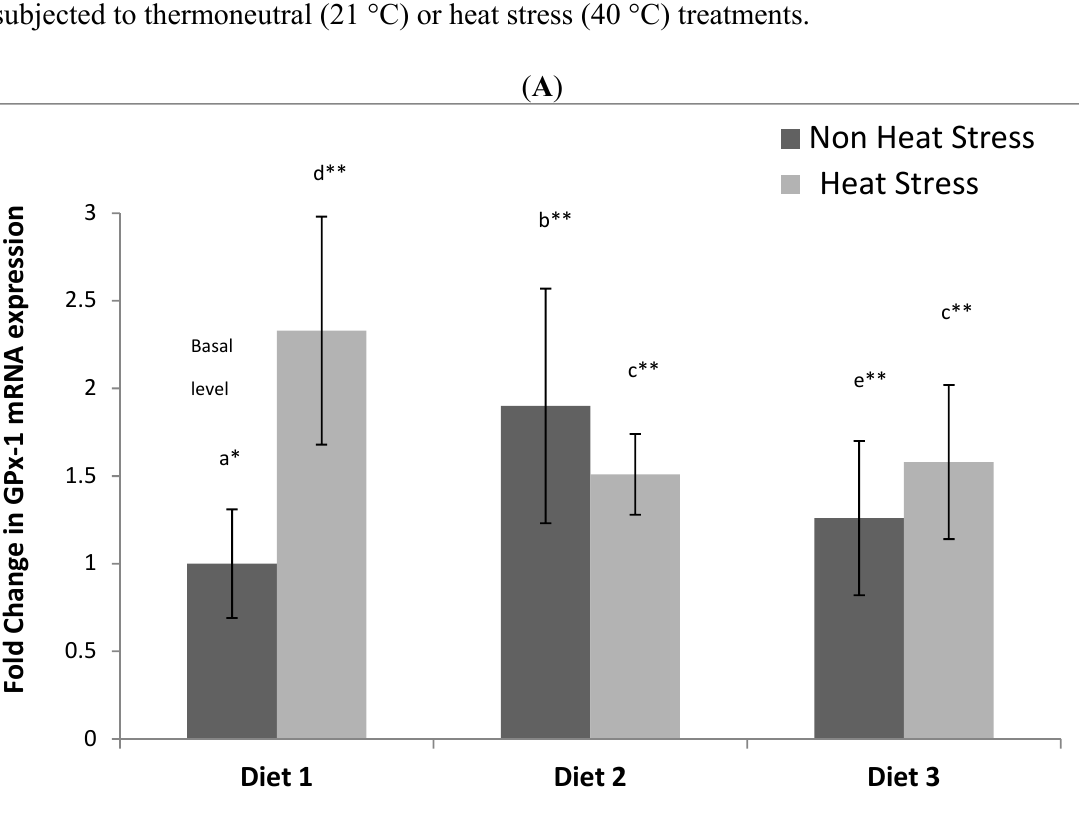
Figure 3. Effect of dietary Se supplementation on ileum ( A ) glutathione peroxidase-1 (GPx-1) and ( B ) glutathione peroxidase-2 (GPx-2) mRNA expression. mRNA levels were measured in triplicate ileum tissues excised from the ileum of each rat fed with control diet 1 (0.12 µg Se/g feed), Se-enriched Diet 2 (1 µg Se/g feed) or Se-enriched + α -tocopherol Diet 3 (1 µg Se/g feed + 300 µg α -tocopherol/g feed), and expression levels normalized against the β -Actin reference gene. Fold change in GPx-1 and Gpx-2 mRNA levels was calculated relative to a basal level from non-heat stress rats on control Diet 1, which was set at an arbitrary expression level of 1. Number shows mean value and standard error for rats on Diet 1 ( n = 7), Diet 2 ( n = 7) and Diet 3 ( n = 7) that were subjected to thermoneutral (21 °C) or heat stress (40 °C)